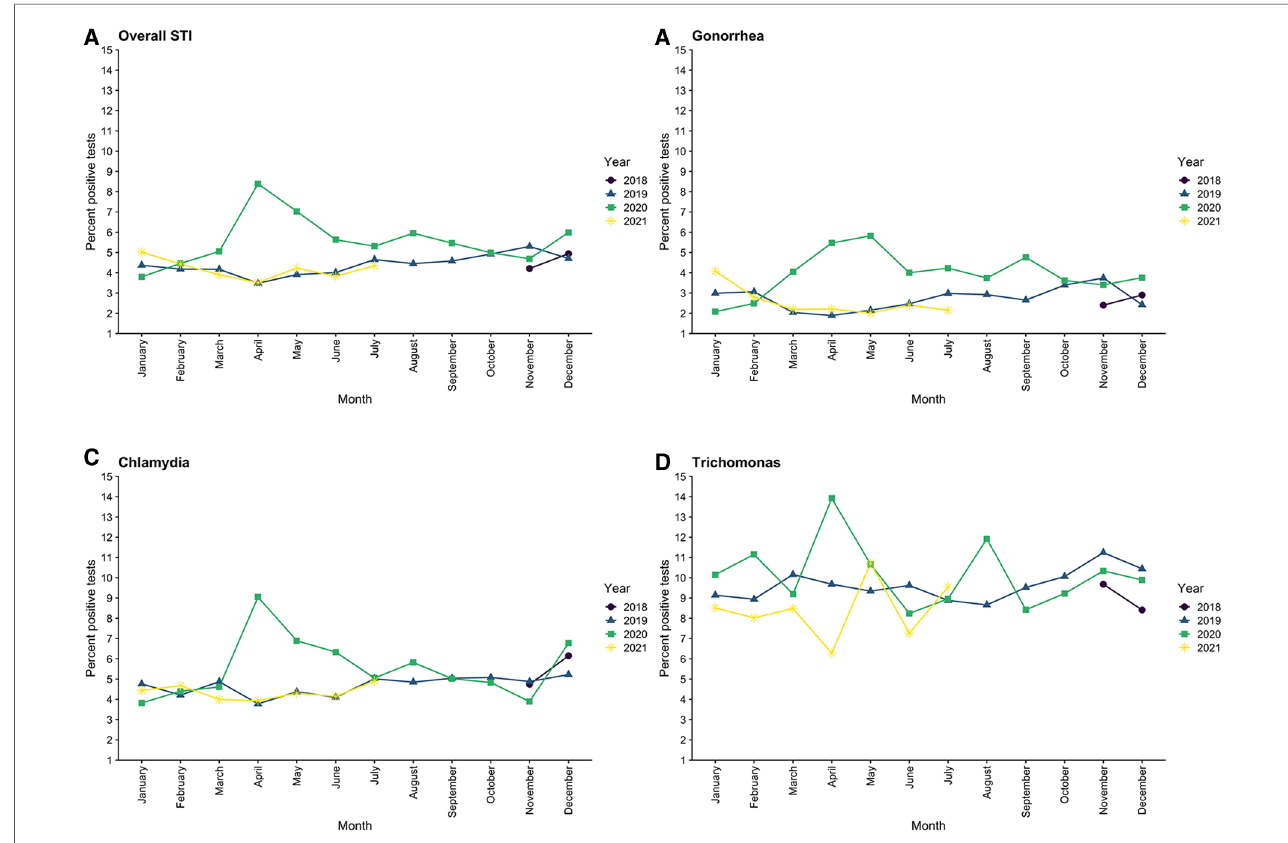
FIGURE 3 Trends in positivity rates for sexually transmitted infections across the entire medical center by month, from November 2018 through July